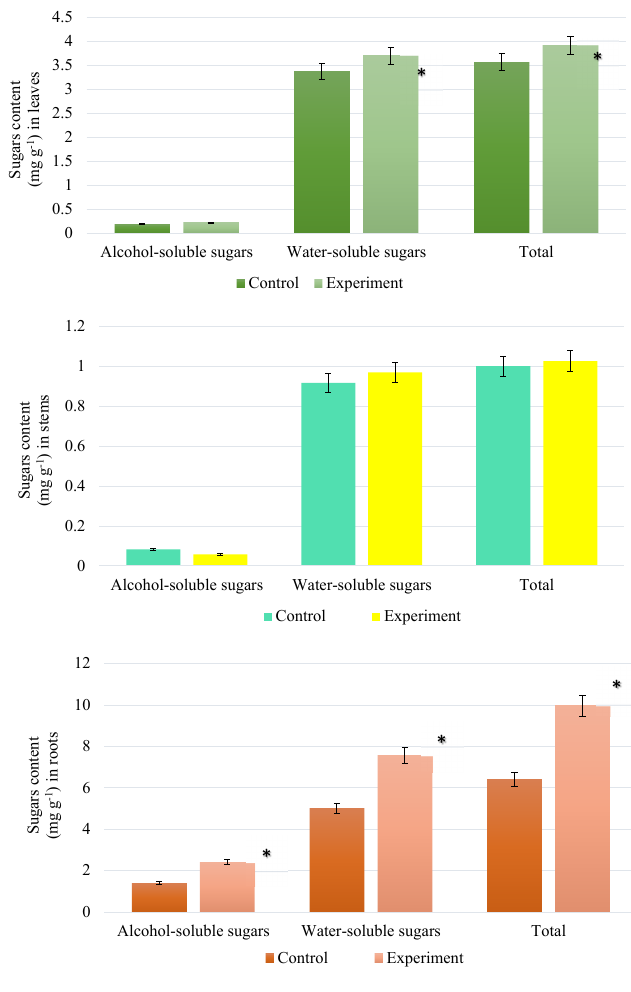
Figure 3 Content of soluble sugars in Salix viminalis under salinity condition (field condition, 120 days of growth): leaves ( A ); stems ( B ); roots ( C ). * Significant difference compared with the control, p <